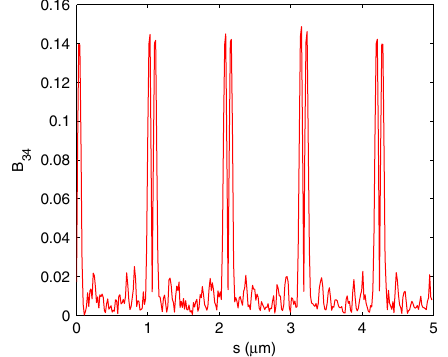
FIG. 5. Local bunching factor distribution along the electron beam at the entrance of the radiator for the third